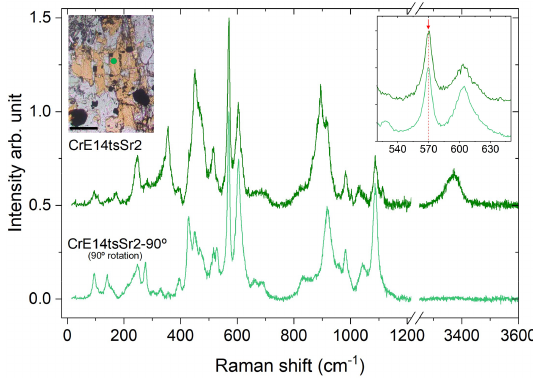
Figure 10. Orientational dependence of the Raman spectra of CrE14tsSr2. The optical microphotograph shows the Sr + Cr- bearing epidote (yellow) corresponding to the orientation of the Ra- man spectrum of CrE14tsSr2 collected (green line). The spectrum of CrE14tsSr2-90 ◦ was collected after 90 ◦ rotation. The scale bar in the microphotograph is 100µm, and the analytical point is repre- sented in the green circle.